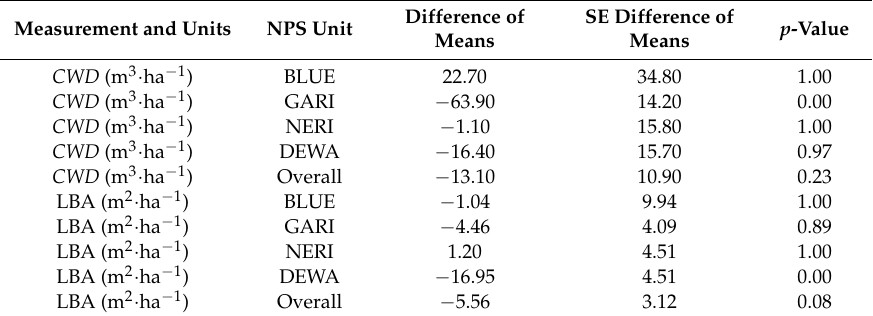
Table A1. Tukey method comparison for differences of means (undisturbed–disturbed) for average coarse woody debris (CWD) volume (m 3 · ha − 1 ) and live basal area (LBA) (m 2 · ha − 1 ) for all undisturbed plots versus the disturbed plots for each National Park Service (NPS) unit and all units combined prior to the disturbance events.